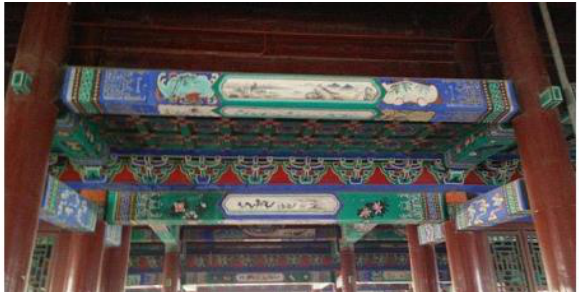
Figure 3. The second floor of the theater building